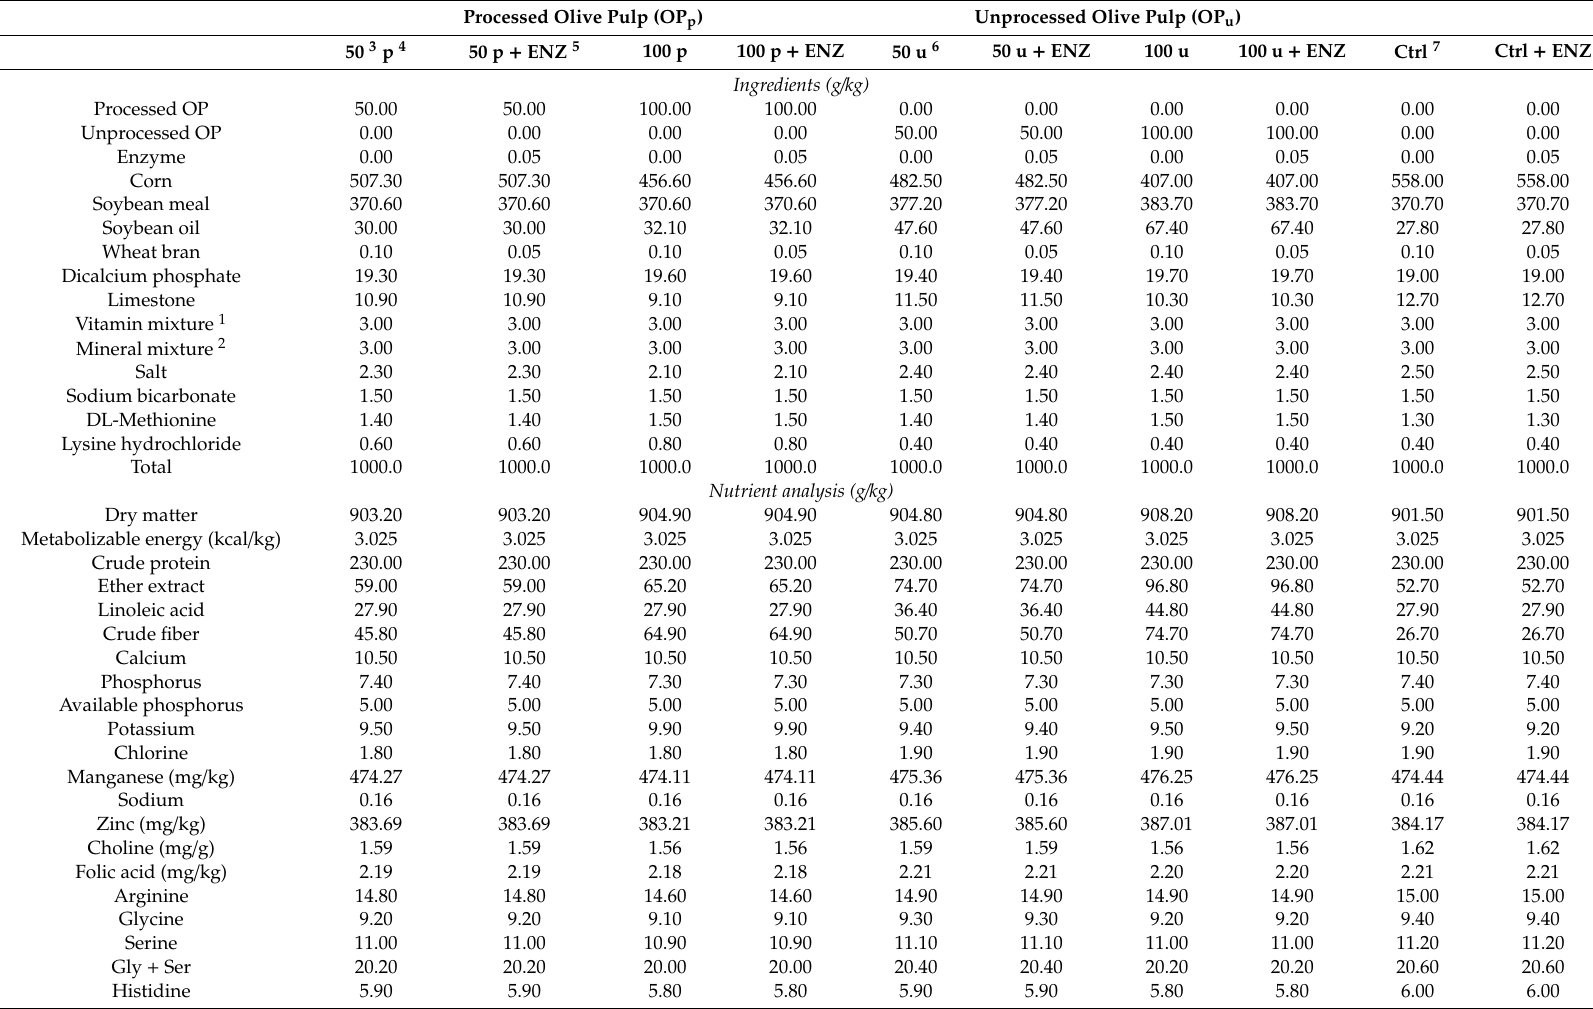
Table 1. Feed ingredients and chemical composition of diets used during the starter period (1st–21st days of age, as-fed basis).